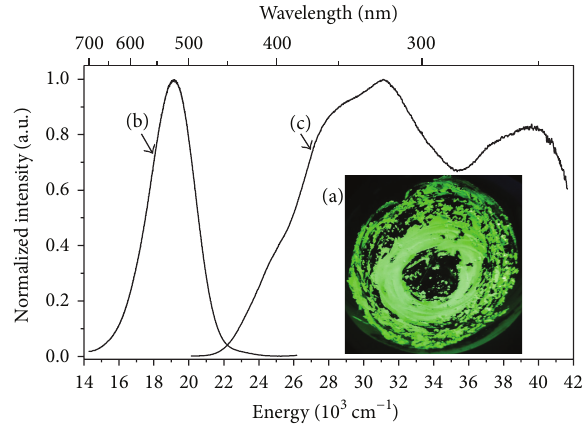
Figure 5: (a) 4 after annealing under reductive atmosphere, irra- diated with UV light. (b) Emission ( ̃𝜐 = 19 417cm −1 ) spectra of reduced 4 at room excitation ( ̃𝜐 em temperature.